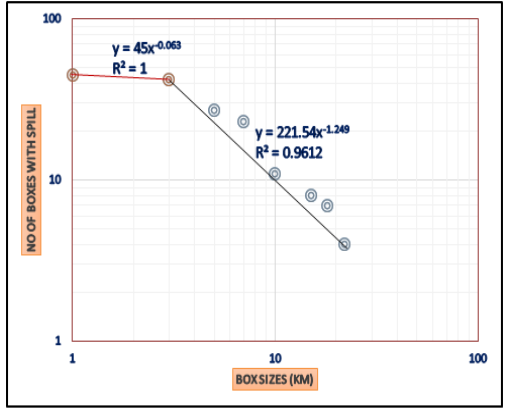
Figure 8. Box count dimension of oil spill vandalization